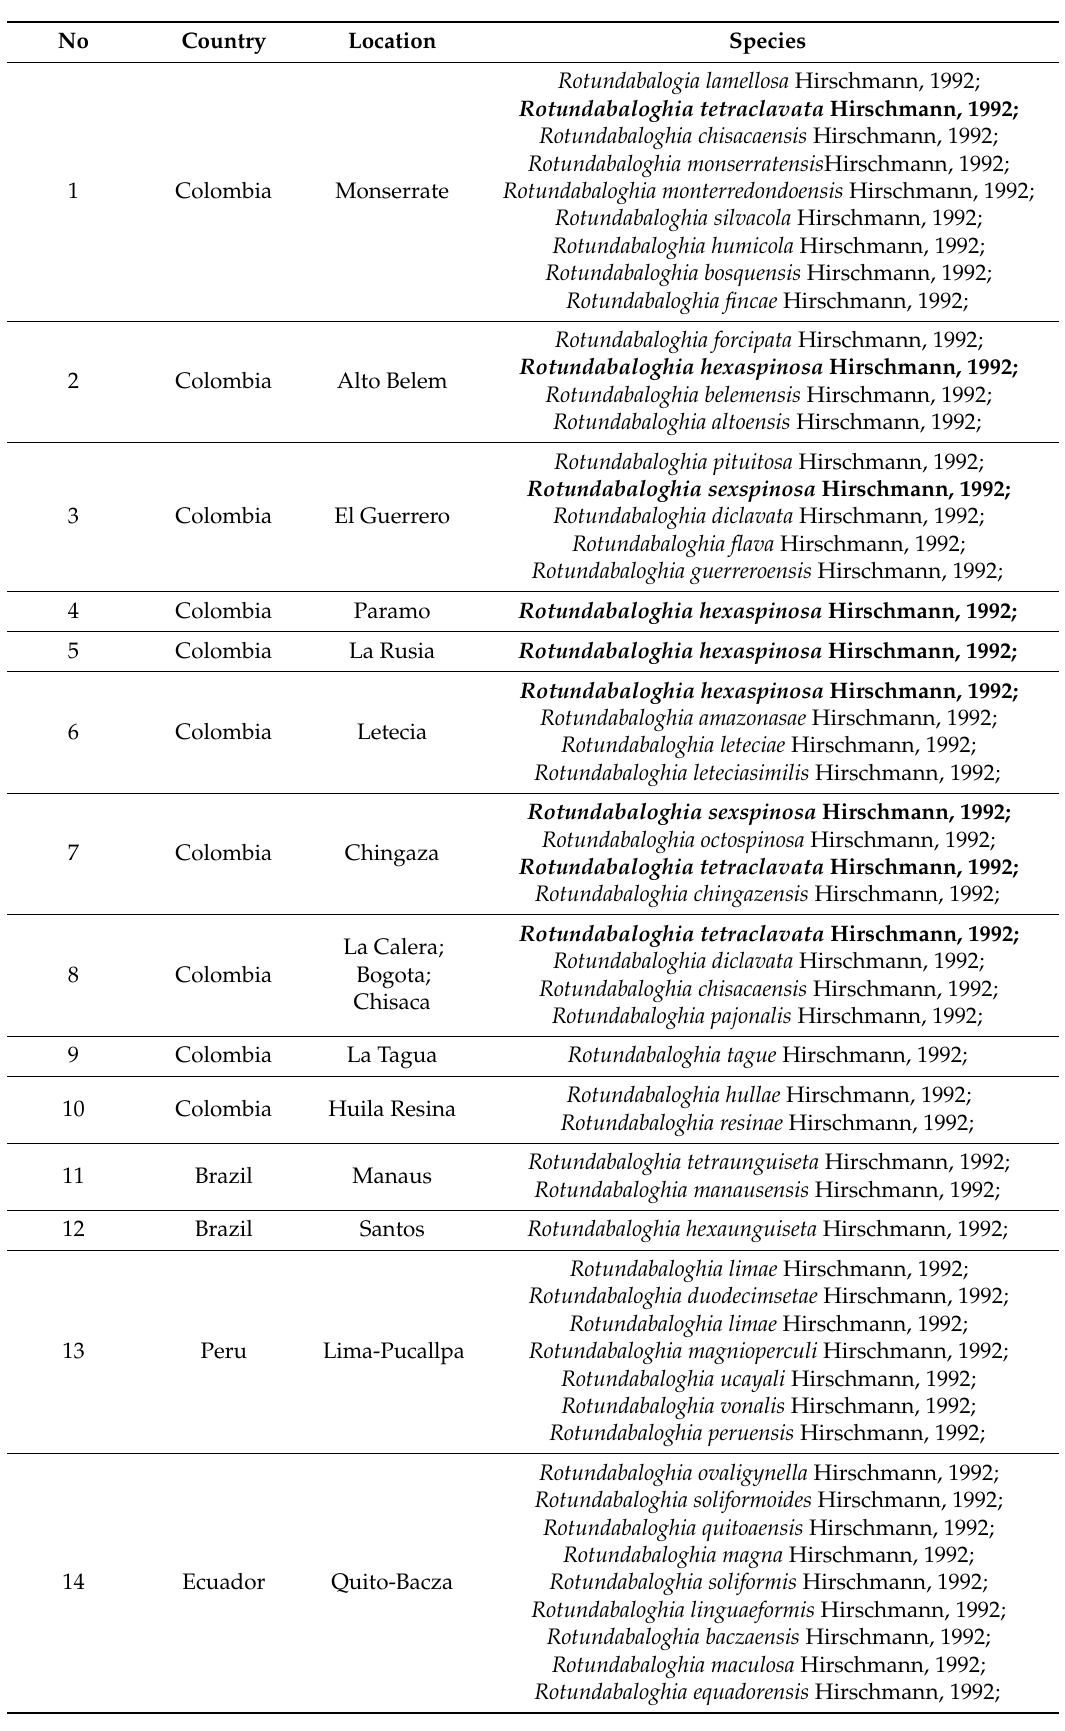
Table 2. List of species from the genus Rotundabaloghia described by Hirschmann in 1992 [25] from the area of South America (numbers of sites are the same as on the map). Species in bold were found in more than one